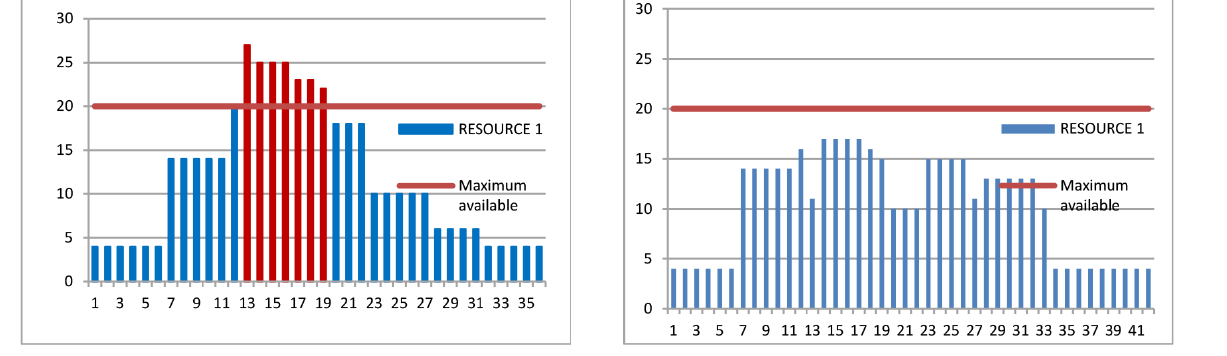
Figure 17. Daily usage of resource 1 throughout the calendar of the project (before using the method)-Experiment 1